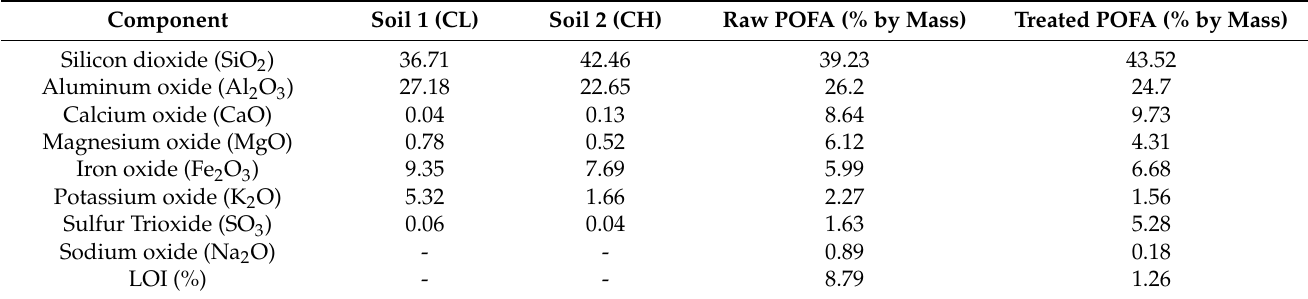
Table 2. Chemical composition of CL, CH and